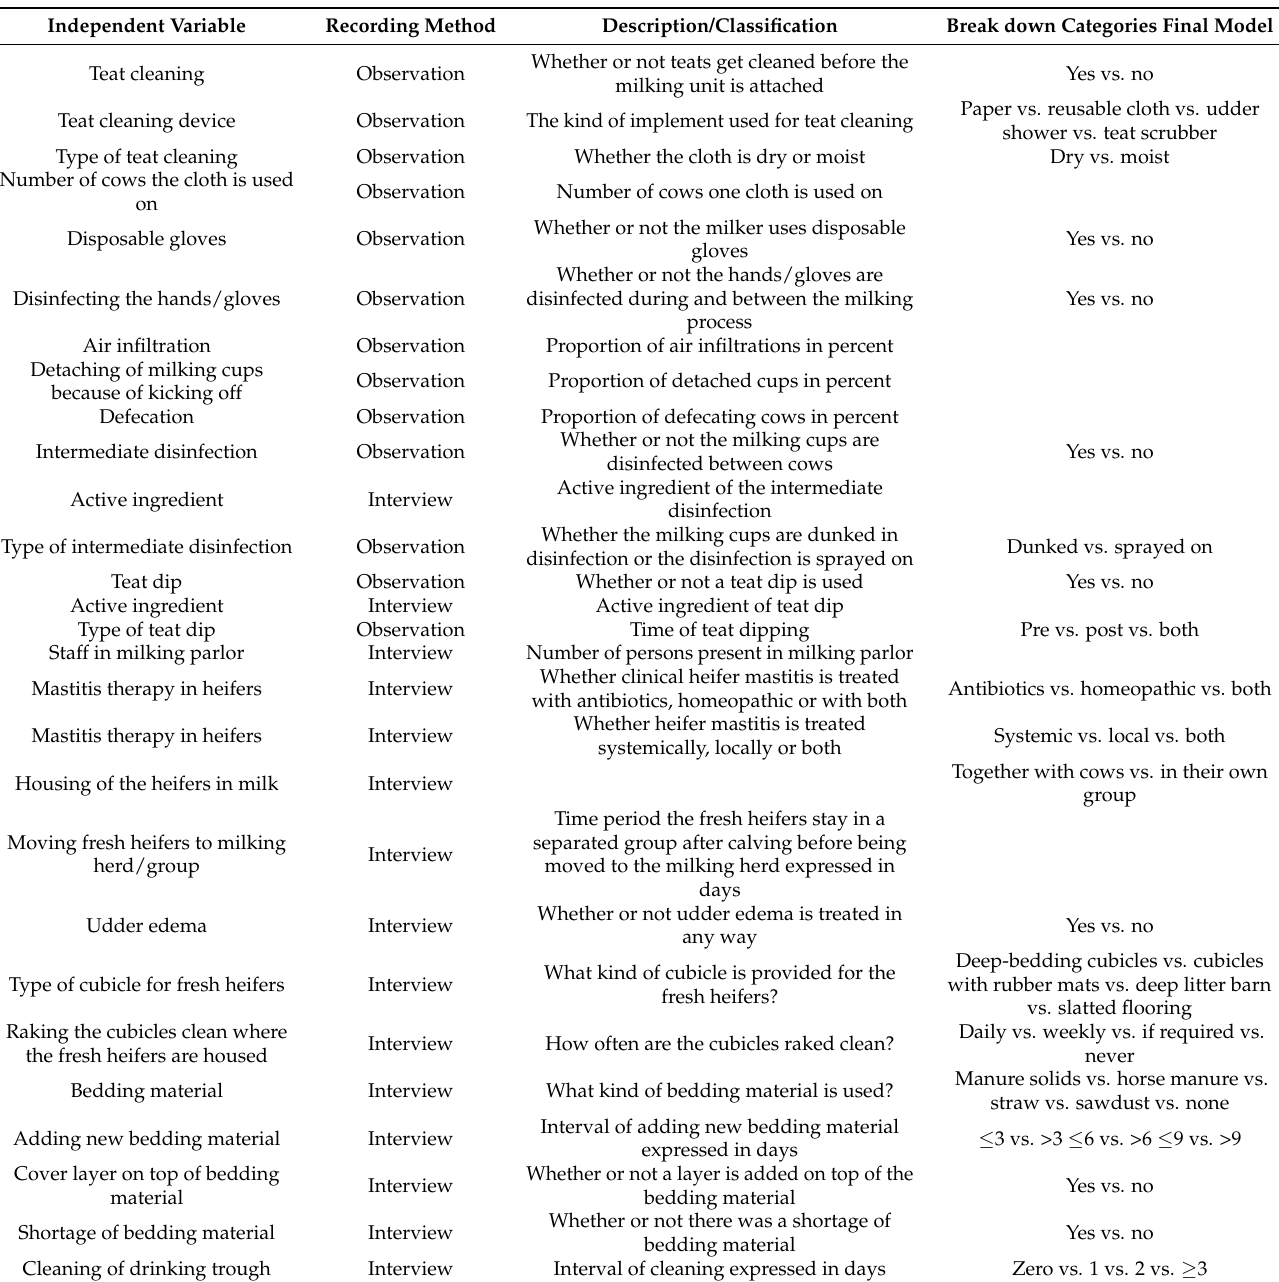
Table 1. Management-related questions about possible risk factors after calving and risk factors assessed by observation during the milking